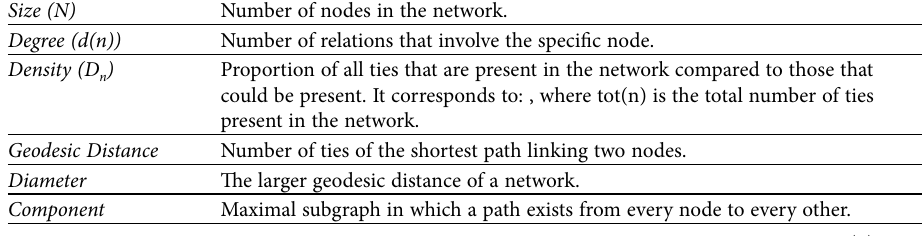
Table 1. Some classical Social Network Analysis indexes.